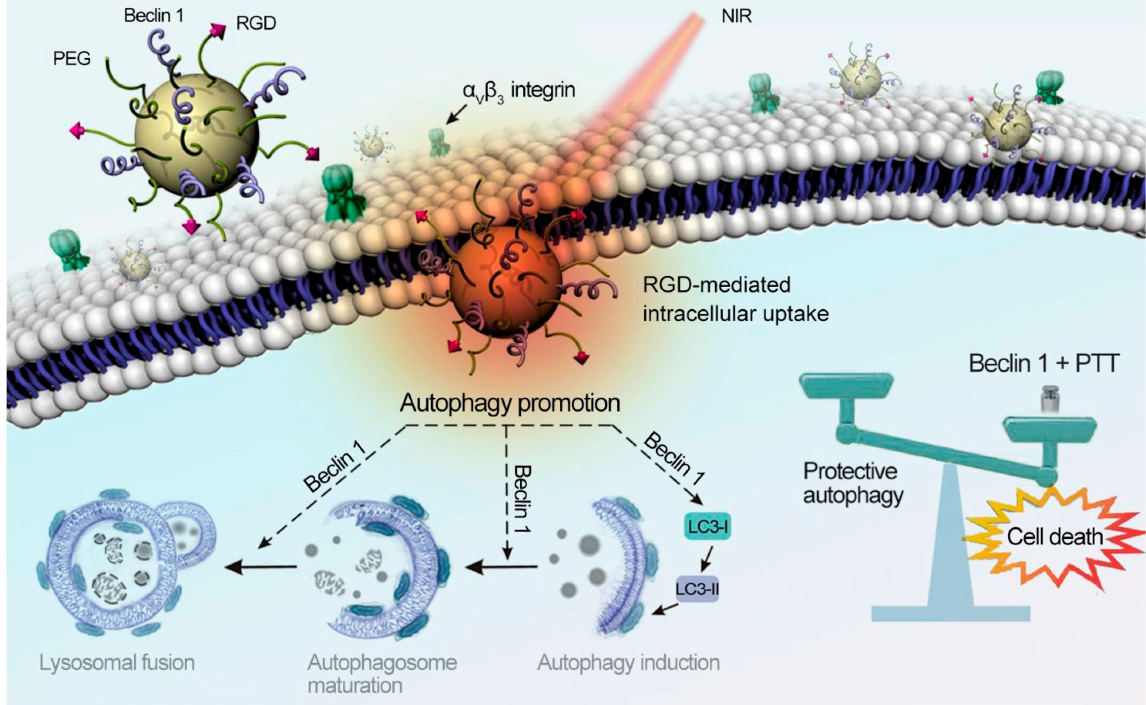
Figure 7. The illustration depicts 1 - induced autophagy sensitizing photothermal killing of cancer cells. PPBR was internalized by cancer cells via RGD - α v β 3recognition. Beclin 1 on the nanoparticle surface up-regulated autophagy to sensitize cancer cells to PTT. Reprinted with permission from Ref. [34]. Copyright 2019 Elsevier.